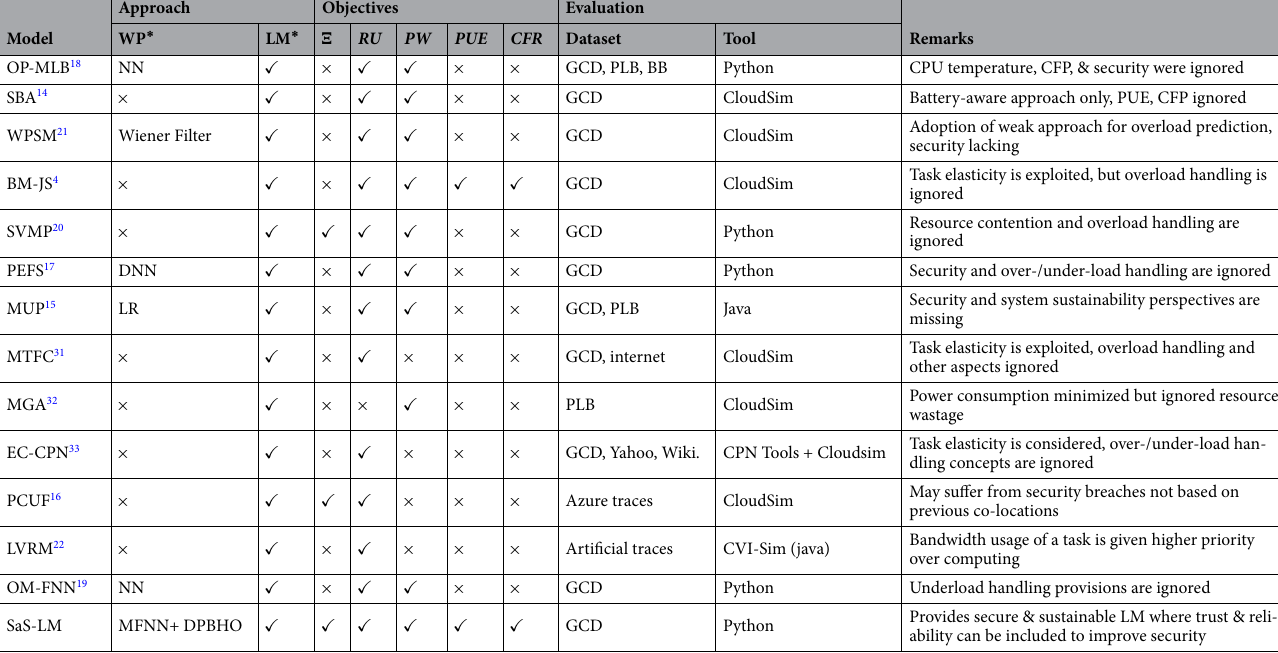
∗ ∗ : Workload prediction, LM